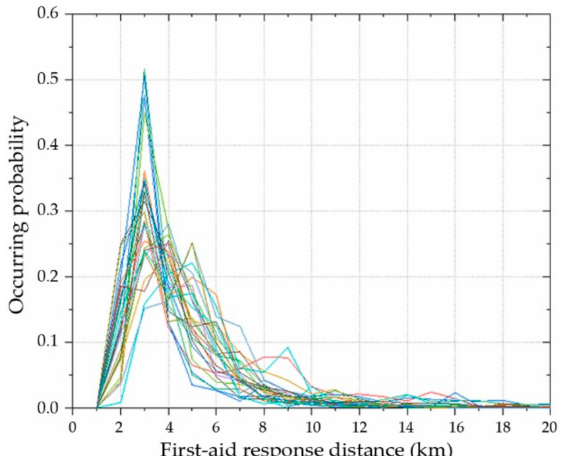
Figure 5. First aid response distance distribution.